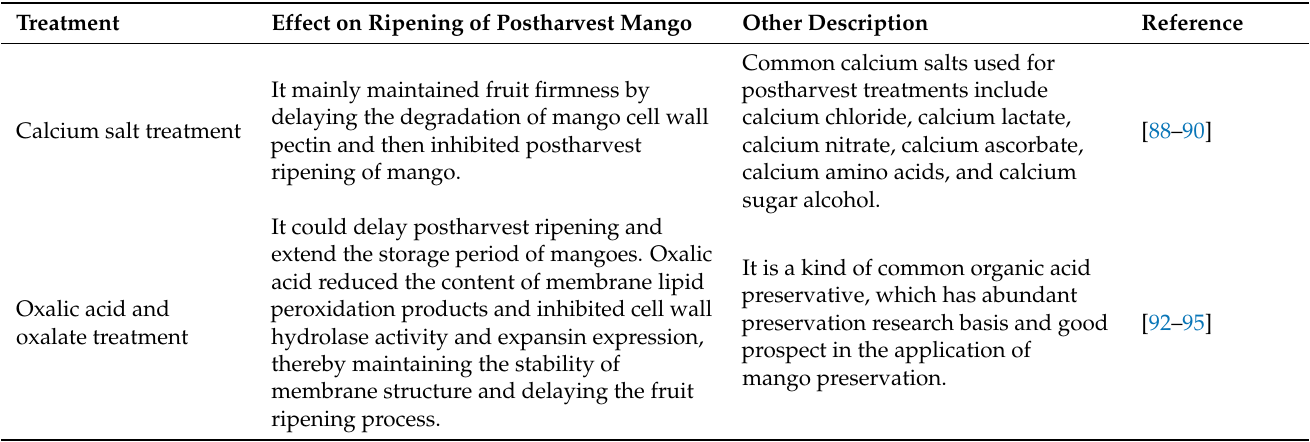
Table 2. Effects and comparison of different chemical treatments on postharvest mango